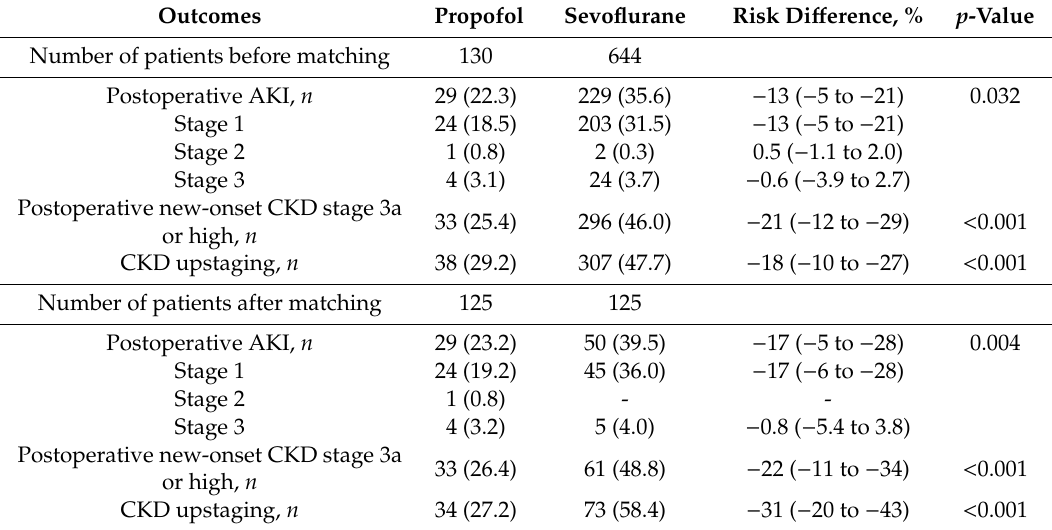
Table 2. Comparison of incidence of primary and secondary outcomes between patients according to the main anesthetic agents during surgery before and after propensity score matching.